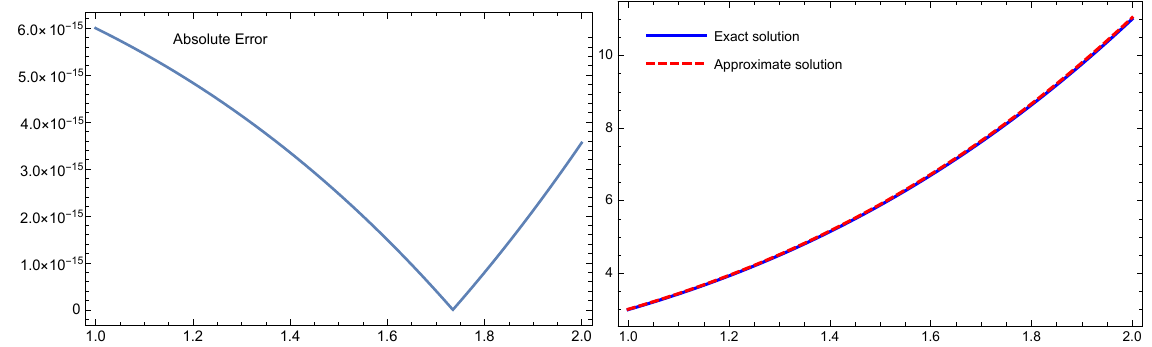
Figure 3. The exact and an approximate are shown on the right, while the absolute error is shown on the left for Example 2 where t ∈ I 2 and m =